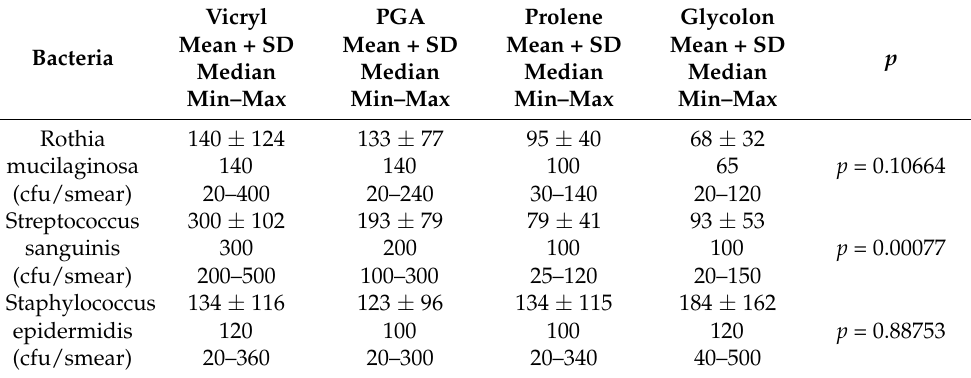
Table 3. The number of bacteria absorbed on the surface of the threads during the operation.